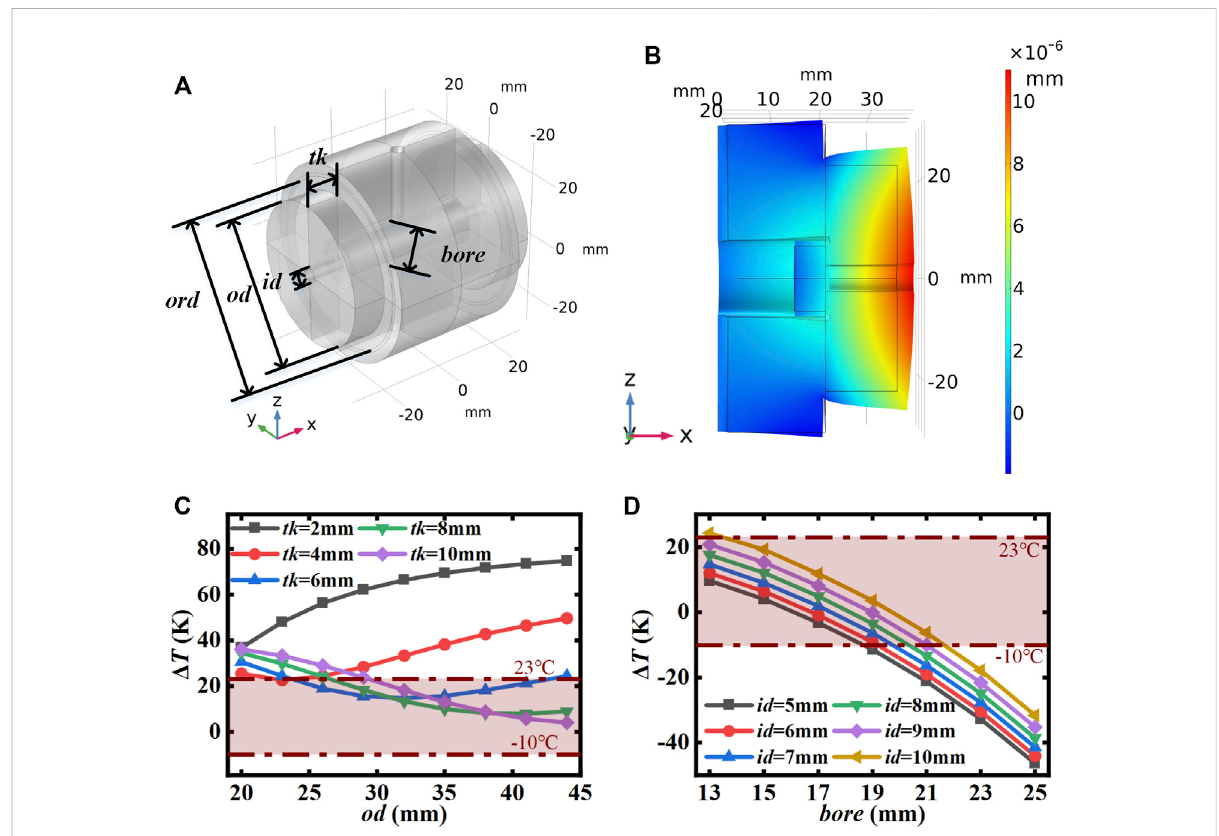
FIGURE 2 (A) 3D model of the “ re-entrant ” structure cavity. (B) FEA simulations of the “ re-entrant ” structure cavity deformation after a 1-K temperature step. (C) Compensation temperature difference for ring inner diameter of 5 mm and bore-aperture of 15 mm. (D) Compensation temperature differenceforringouterdiameterof44 mmandringthickness of10 mm ord ,O-ringdiameter; id , ringinnerdiameter; tk ,ringthickness; bore , bore- aperture; od , ring outer diameter.